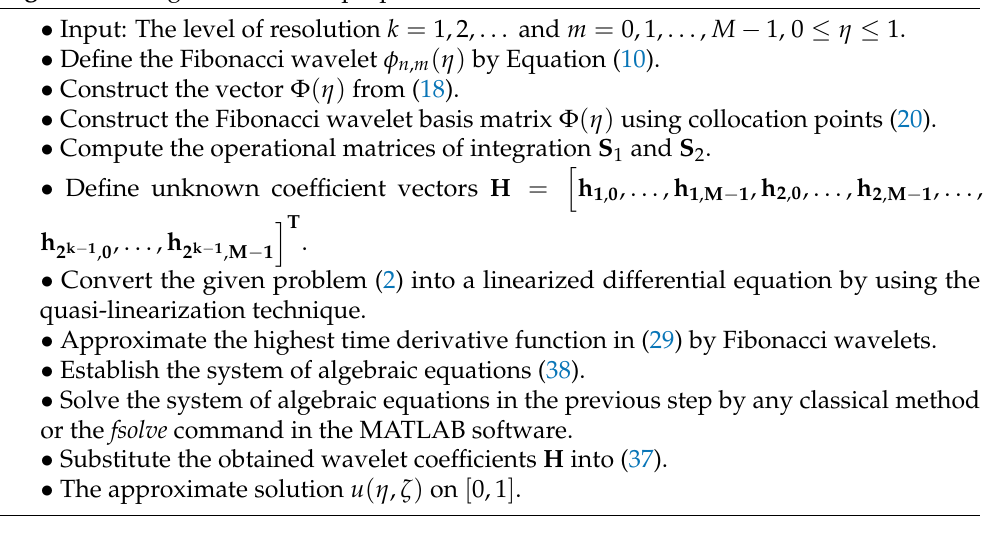
Algorithm 1 Algorithm for the proposed Fibonacci wavelet